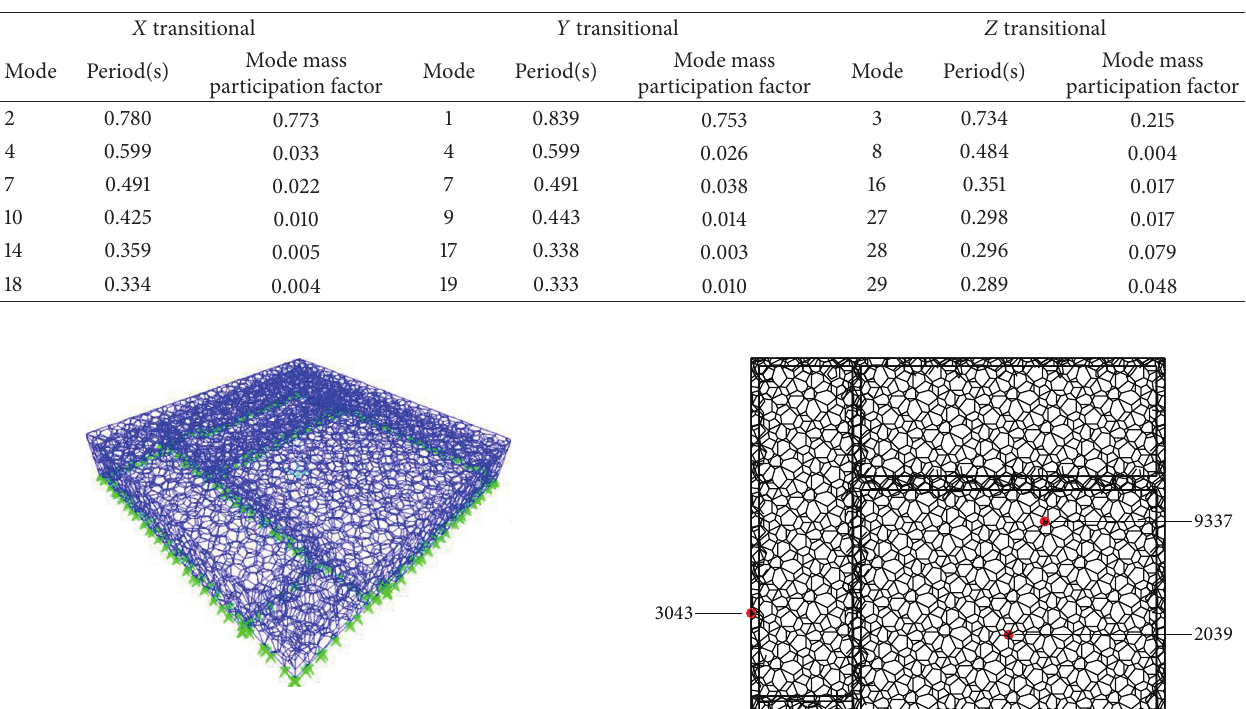
Table 1: The main natural frequencies of the intact shell structure.